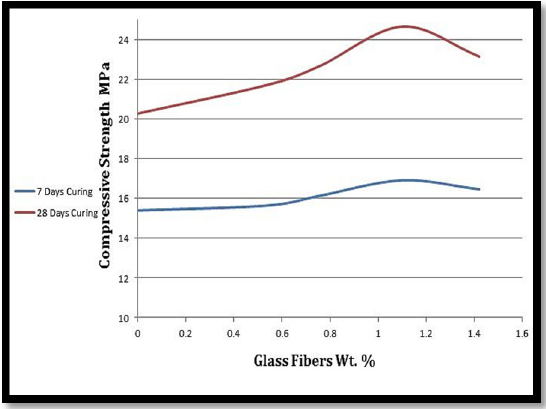
Fig. 8. Effect of random glass fibers addition on mortar after curing for 7 and 28